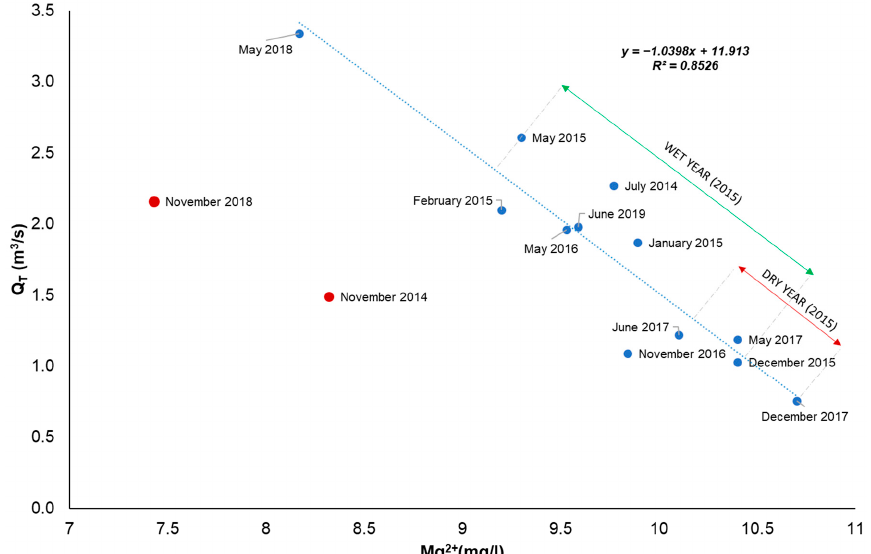
Figure 4. Mg 2+ vs. Pertuso Spring total monthly discharges scatter plot. The double red arrow highlights a very important drought event occurring in 2017.